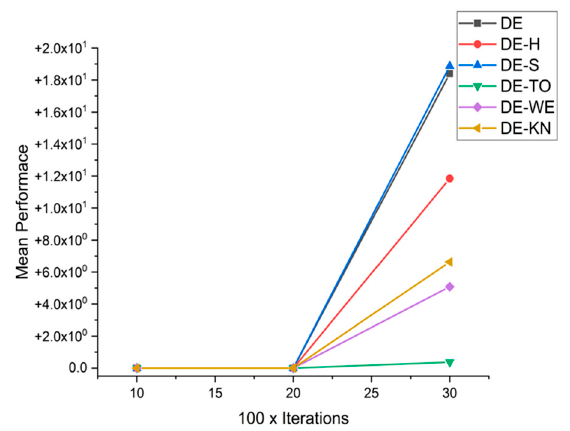
Figure 24. Convergence curve on fn2.